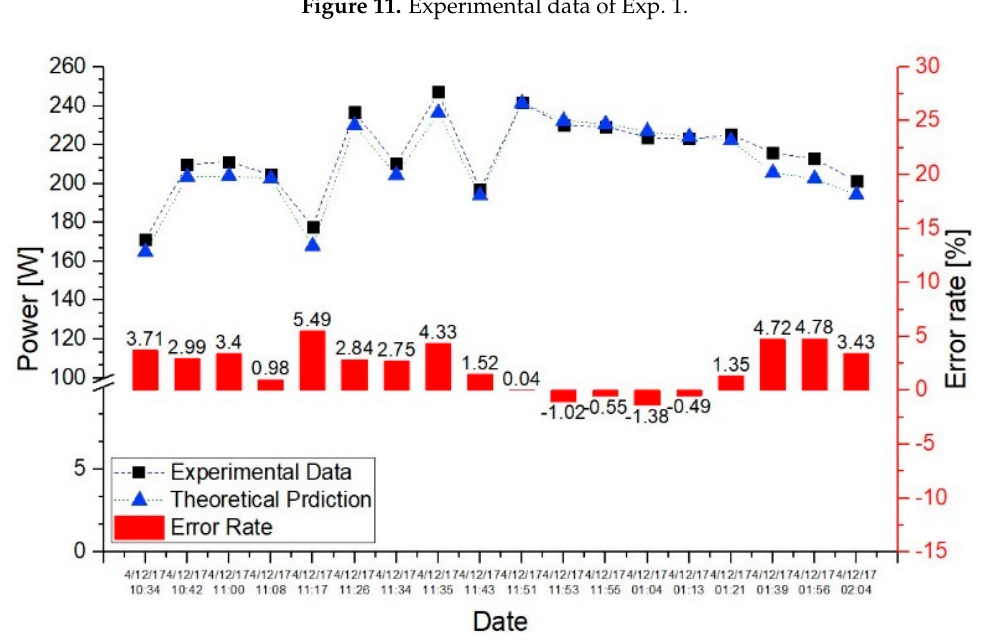
Figure 12. Experimental data of Exp. 2.